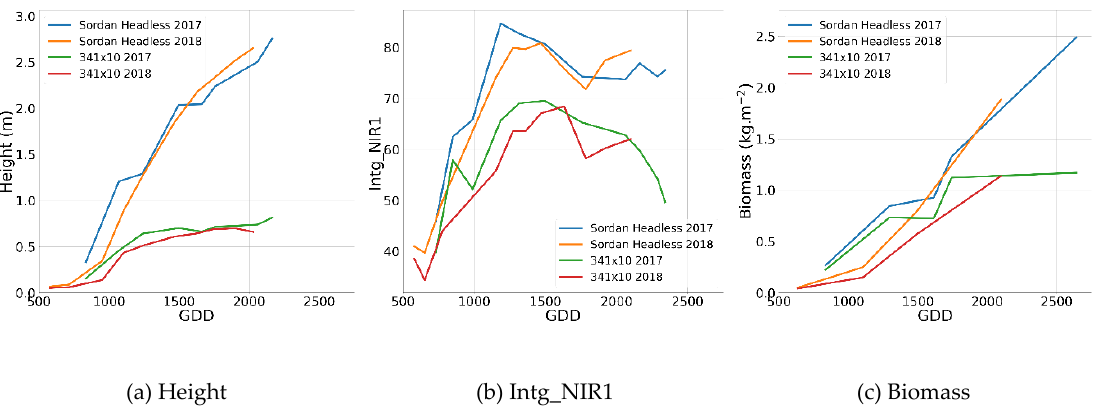
Figure 13. Comparison of the 90th percentile height ( a ), Intg_NIR1 ( b ), and the biomass data ( c ) for the dwarf grain sorghum 341 × 10 and the photoperiod sensitive Trudan Headless varieties in the 2017 and 2018 growing seasons.